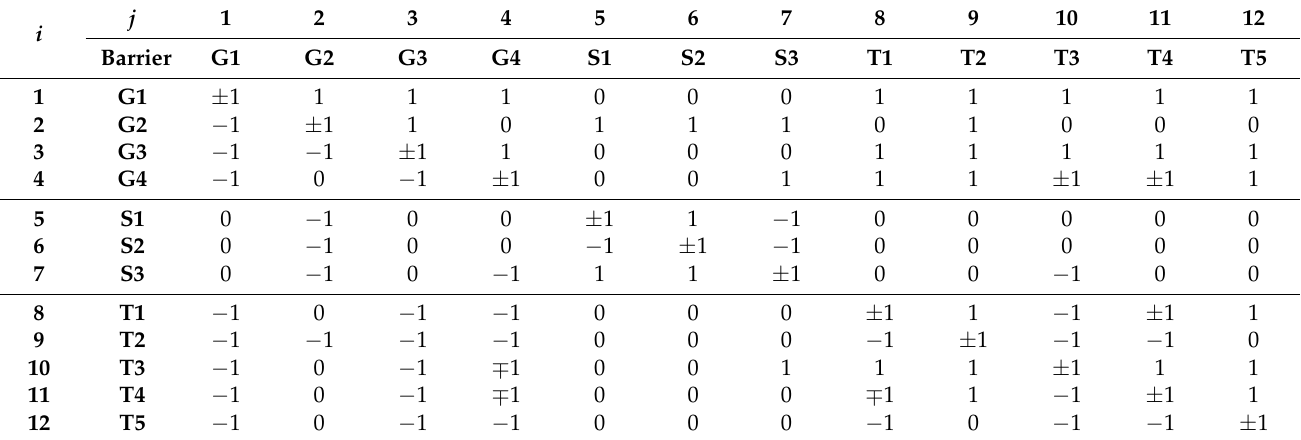
Table 5. Initial Reachability Matrix (RM init ).